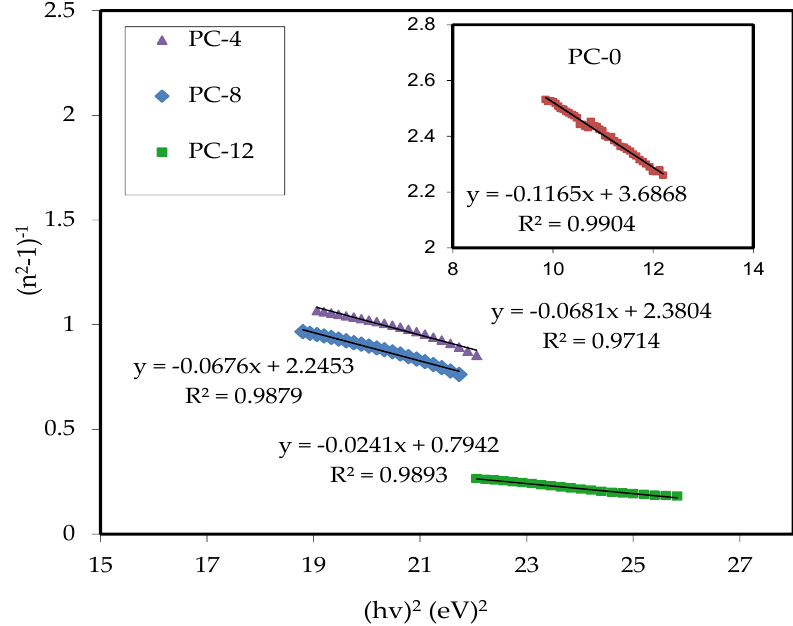
(cid:0) (cid:1) − 1 n 2 − 1 Figure 15. Variation of against photon energy ( hv ) 2 for the Figure 15. Variation of (𝑛 (cid:2870) − 1) (cid:2879)(cid:2869) against photon energy (ℎ𝑣) (cid:2870) for the samples. Table 7. Optical band gap calculated from the single oscillator model, established by Wem- ple–DiDomenico.